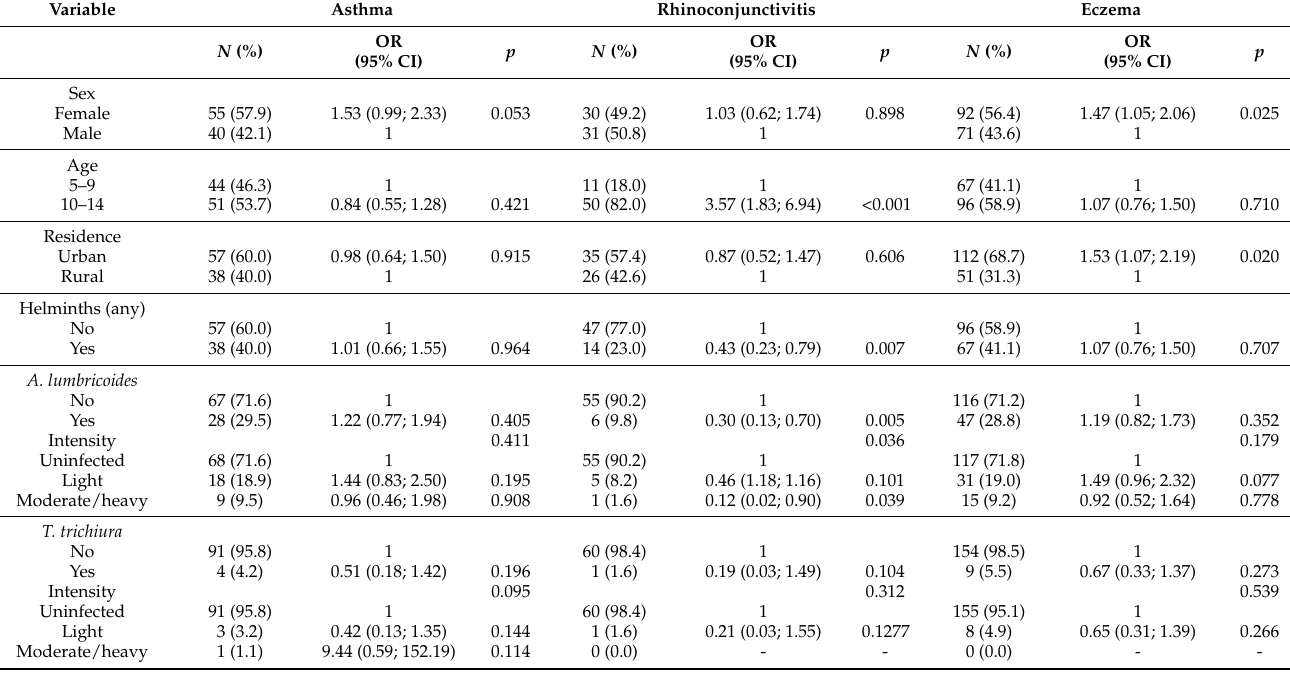
Table 2. Univariate analyses for allergic